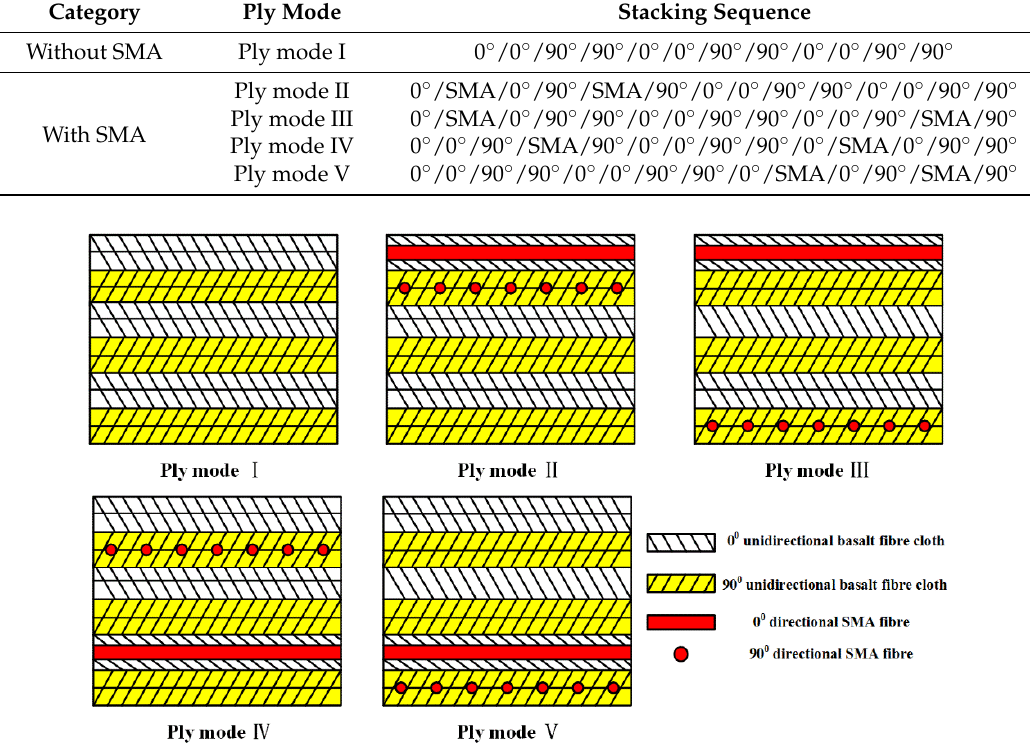
Figure 3. The schematic diagram of the VARI process.